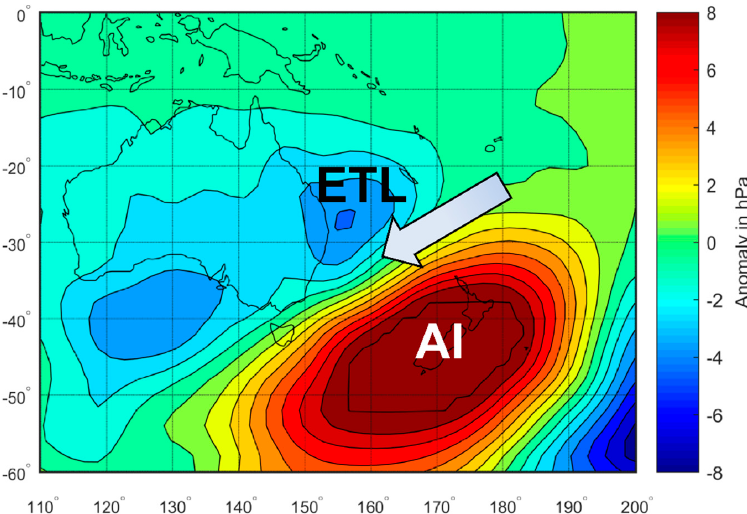
Figure 2. Composite sea level pressure (SLP) anomaly (in hectopascals, hPa) for all east ‐ northeast Anticyclonic Intensification (AI)/Easterly Trough Low (ETL) storm wave events since 1974, using events identified from buoy records in Shand et al. [9], and the European Centre for Medium ‐ Range Weather Forecasts (ECMWF) ERA 20th Century reanalysis (ERA ‐ 20C) [14]. The composite anomaly was calculated relative to the ERA ‐ 20C long ‐ term mean (1900–2010).